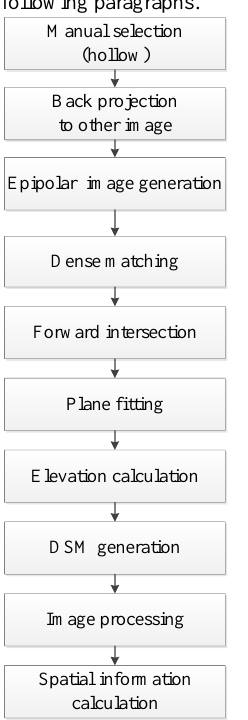
Figure 9. The workflow of concrete spalling